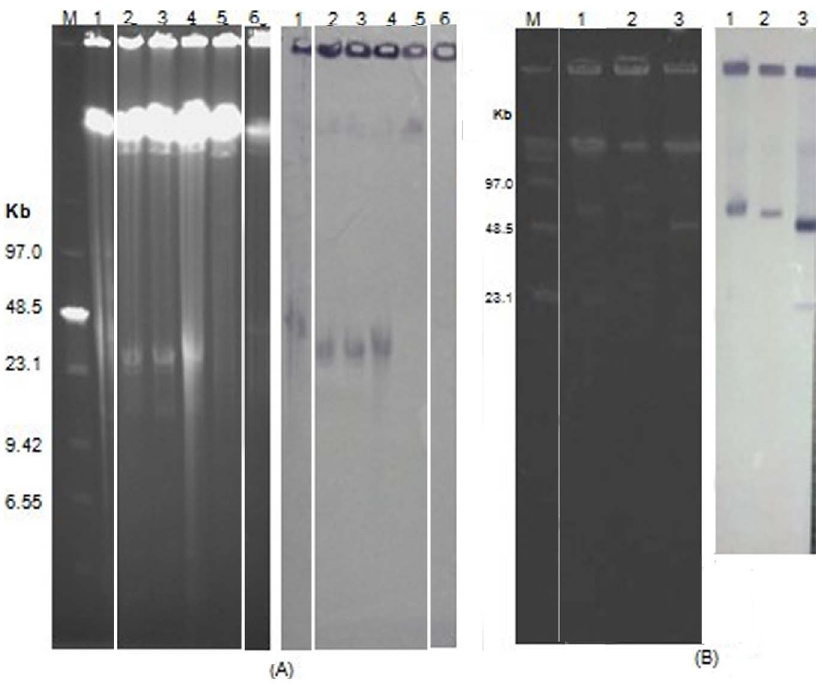
Figure 2. Result of S1-PFGE and Southern blot hybridization. (A) The left dark background figure shows the results of S1-PFGE, while the right light background shows the Southern blot hybridization. M: Low Range PFG Marker. Lane 1 , 6: A. calcoaceticus G113, K. pneumoniae M186, K. pneumoniae M187, K. pneumoniae M194, K. pneumoniae U091 and Citrobacter freundii X122, respectively. (B) The left dark background figure shows the results of S1-PFGE, while the right light background shows the Southern blot hybridization. M: Low Range PFG Marker. Lane 1 , 3: Enterobacter cloacae Q297, Enterobacter aerogenes Q442 and A. calcoaceticus X231,